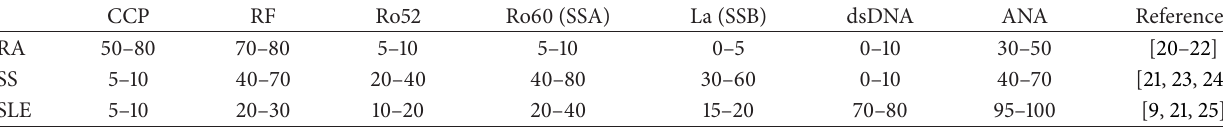
Table 1: Prevalence (%) of autoantibodies in RA, SS, and